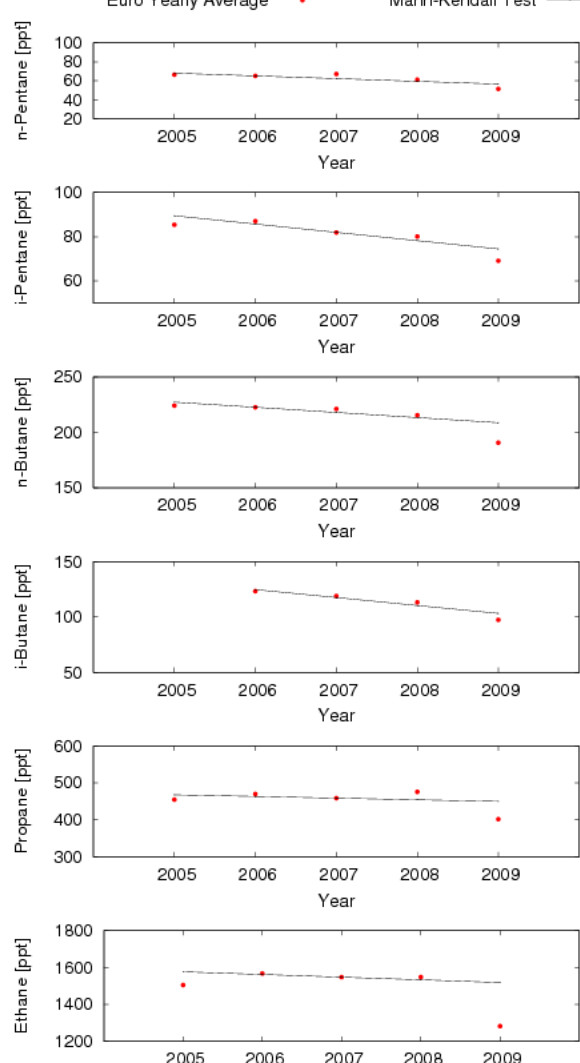
Figure 4: Yearly averaged data from European air masses arriving at Mace Head (circles) 2 Fig. 4. Yearly averaged data from European air masses arriving at Mace Head (red circles) with the line computed from use of the with the line computed from use of the Mann-Kendall test for the presence of significant 3 Mann-Kendall test for the presence of significant trend. 4